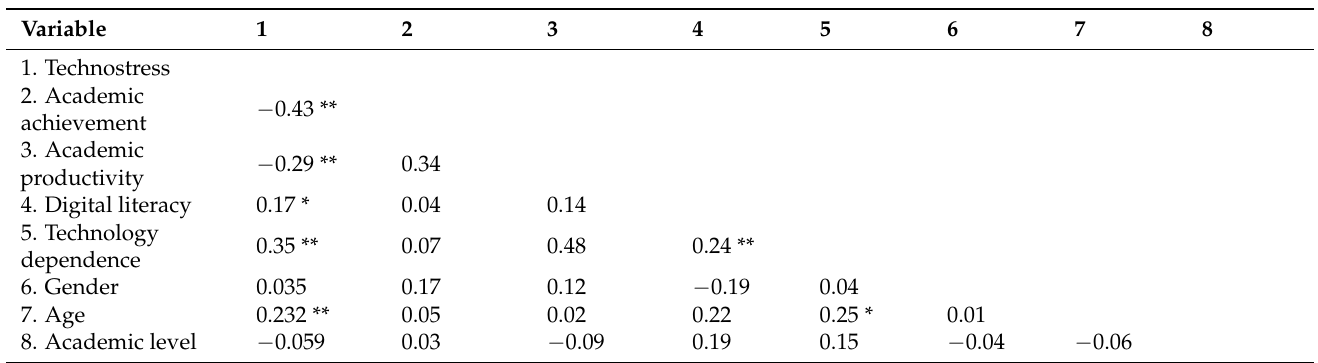
Table 9. Bivariate Correlations matrix.